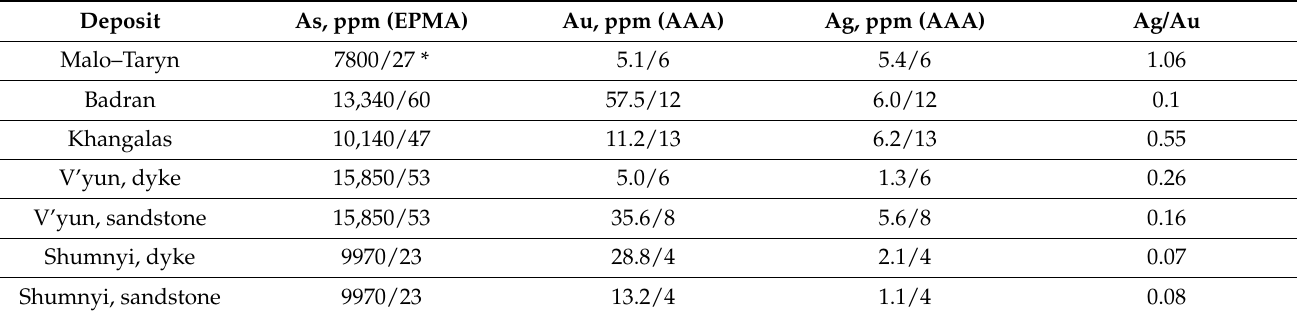
Table 6. Mean values of As, Au, and Ag in pyrite from the studied OGDs, central